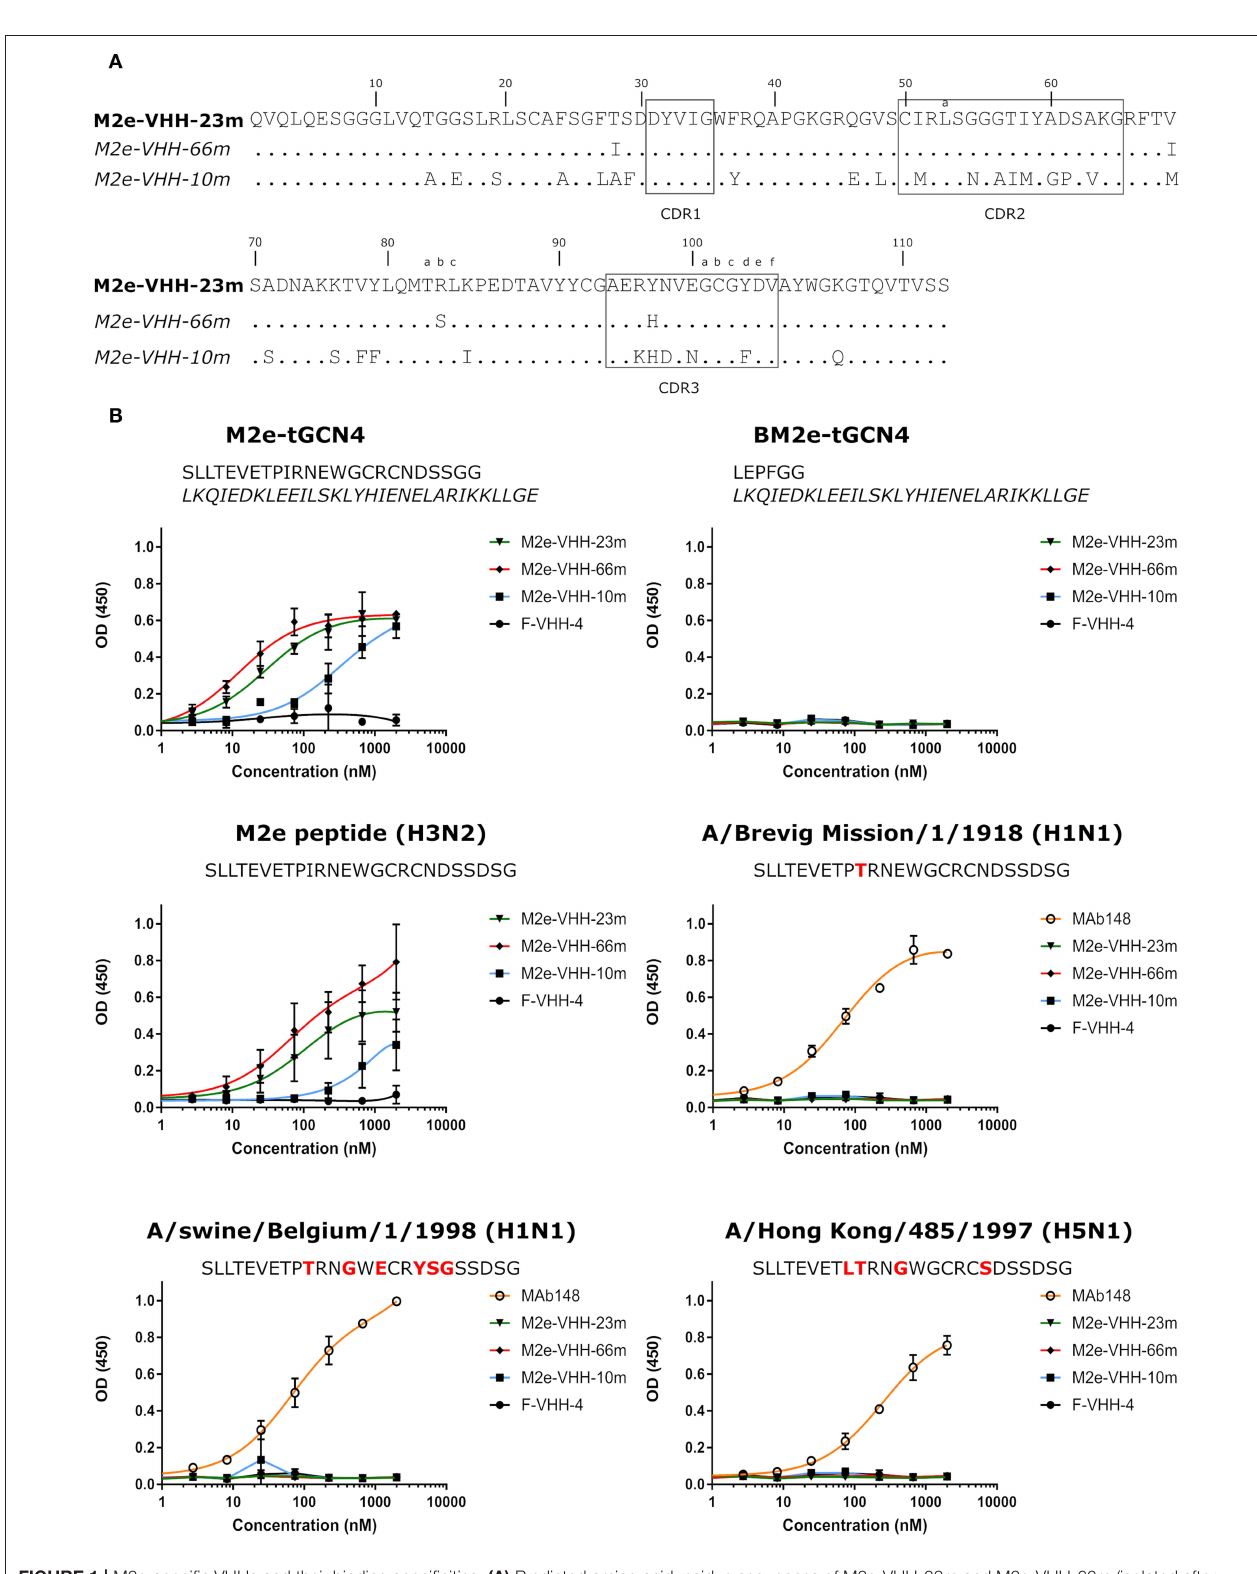
FIGURE 1 | M2e-specific VHHs and their binding specificities. (A) Predicted amino acid residue sequences of M2e-VHH-23m and M2e-VHH-66m (isolated after panning on M2e-tGCN4 and human H3N2 M2e peptide) and M2e-VHH-10m (isolated after panning on HEK cells stably expressing M2). Above the sequences